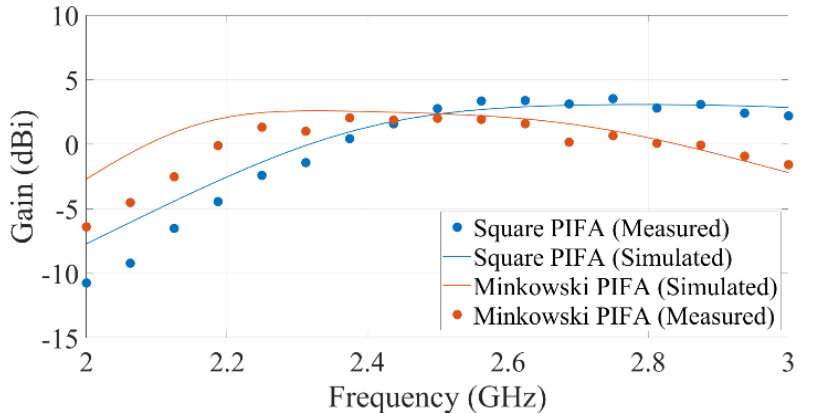
Figure 13. Comparison of measured and simulated gains for the square PIFA and Minkowski pre-fractal-shaped PIFA.